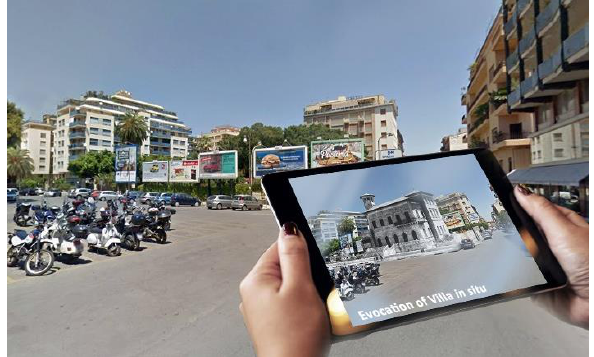
Figure 8. The image shows the use of the application in the outdoor environment, which helps to visualize the architecture (no longer existent) in its original context (graphic design by A.R.D. Accardi,